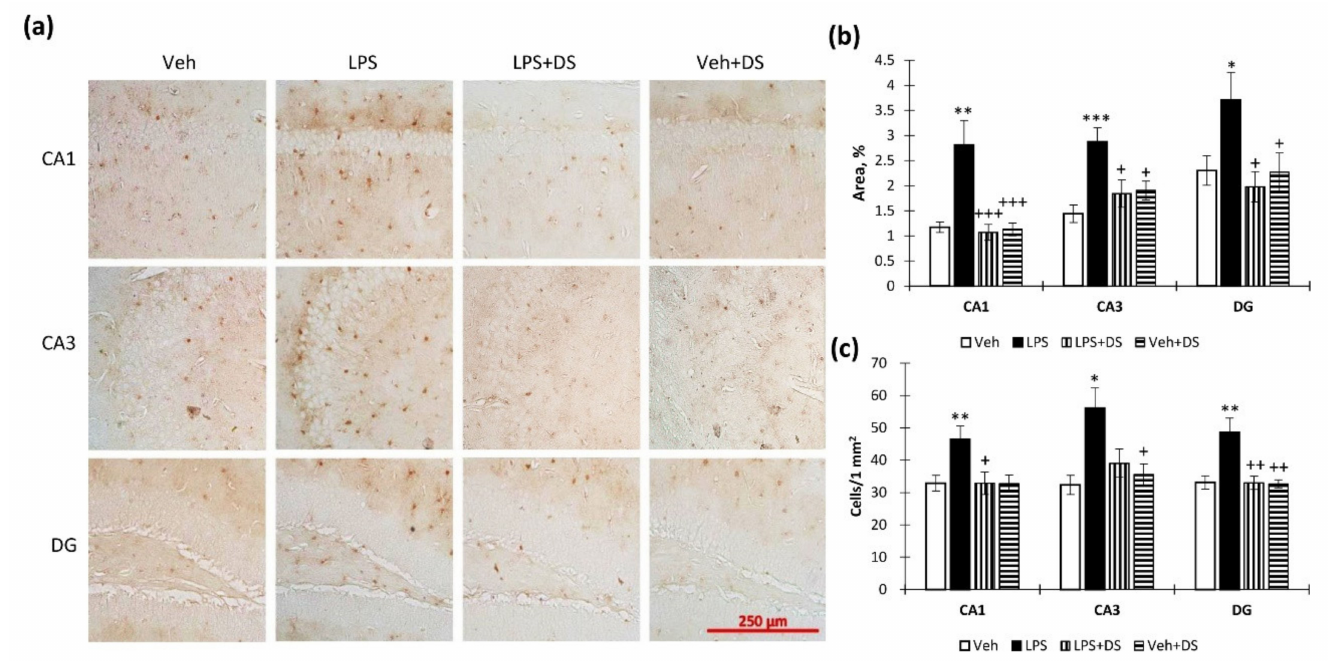
Figure 7. Effect of LPS and DS administration on hippocampal S100 β immunoreactivity. ( a ) Representative images of S100 β + microglial cells in CA1, CA3, and DG. ( b ) Histogram demonstrat- ing the percentage of area covered by S100 β + staining in CA1, CA3, and DG regions. Mean ± SEM, n = 10 (number of animals per group). ( c ) Histogram demonstrating the number of S100 β + -cells in CA1, CA3, and DG regions. Mean ± SEM, n = 10 (number of animals per group). Two-way ANOVA with post hoc Tukey test, * p < 0.05, ** p < 0.01, *** p < 0.001; + p < 0.05, ++ p < 0.01, +++ p < 0.001. *—compared to Veh, +—compared to